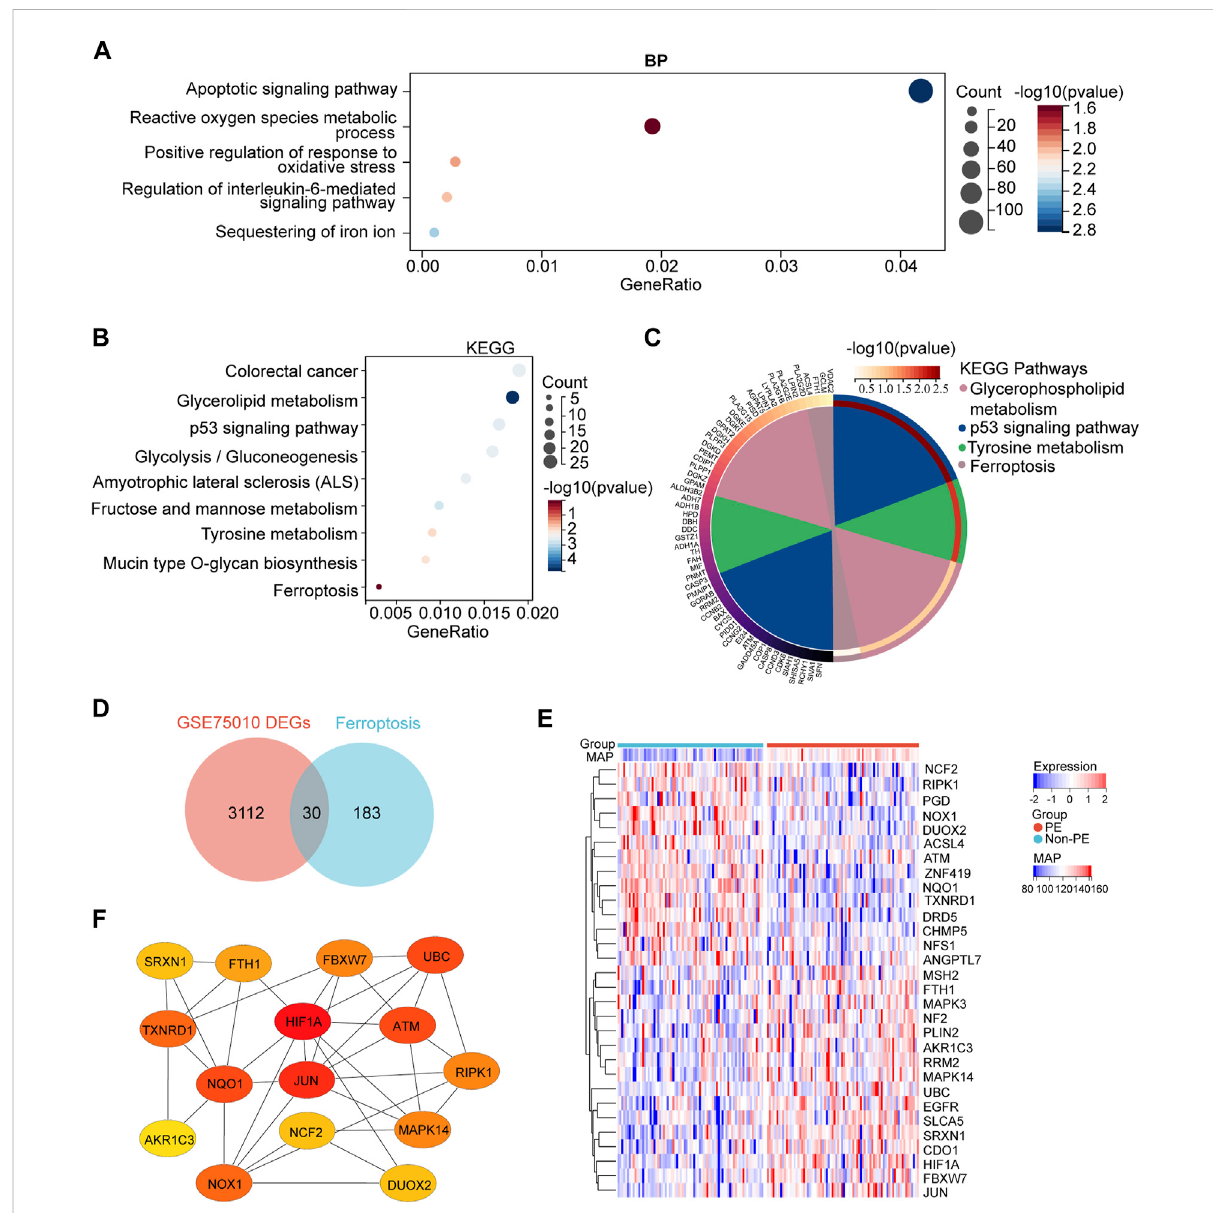
FIGURE 3 GO and KEGG enrichment analyses of DEGs and the identi fi cation of the ferroptosis-related DEGs genes. (A) Bubble plots of the biological processofGOanalysis (B) BubbleplotoftheKEGGpathwayenrichmentofDEGs. (C) CircleplotandnetworkvisualizingtheKEGGpathway (D) Venn diagram of ferroptosis differentially expressed genes. Identi fi cation of ferroptosis-related DEGs by the intersection of ferroptosis dataset with GSE75010. (E) Heatmap depicts the expression levels of ferroptosis-related DEGs among the patients with different MAP. (F) Top 15 hub ferroptosis-related DEGs distinguished using color shading from yellow to red, according to the